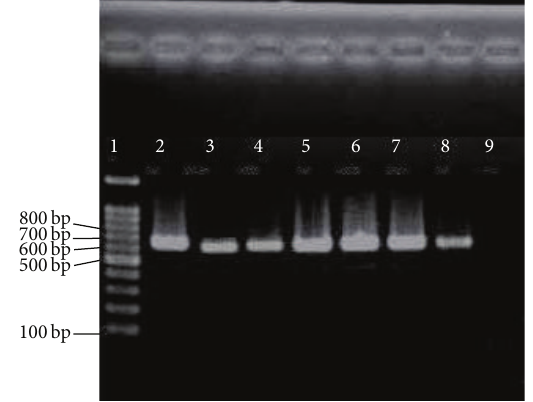
Figure 4: PCR results of fms8 . 1 = marker = 100 bp; 2–8 = fms8 = 765 bp; 9 = negative control.